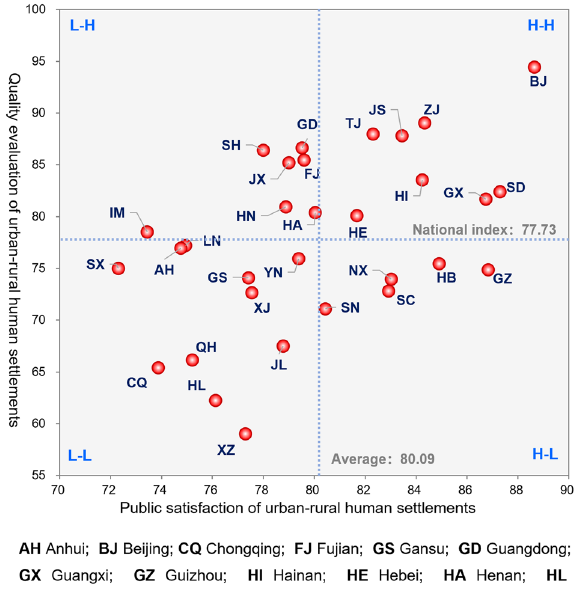
Fig. 7 The relationship between quality evaluation and public satisfaction of urban – rural human settlements in China. It is divided into four quadrants with the medians of quality evaluation and public satisfaction of urban-rural human settlements, namely, H-H, H-L, L-H, and